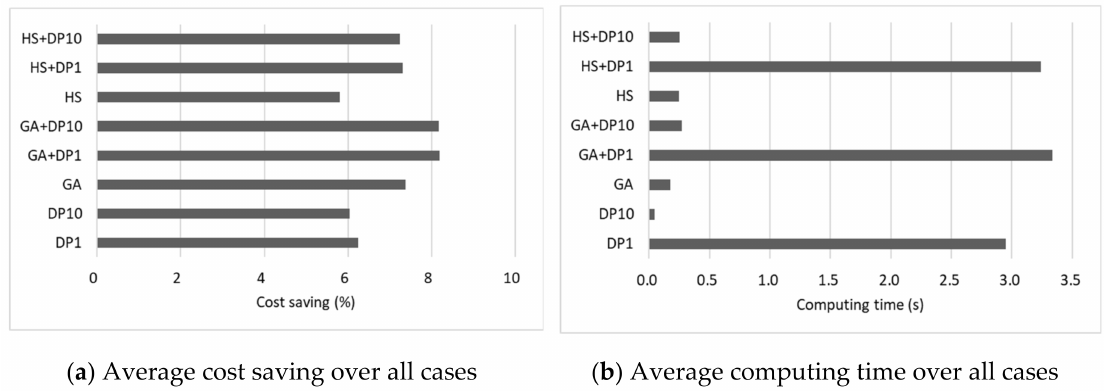
Figure 5. Average cost savings and computing times of the proposed methods with demand charge.